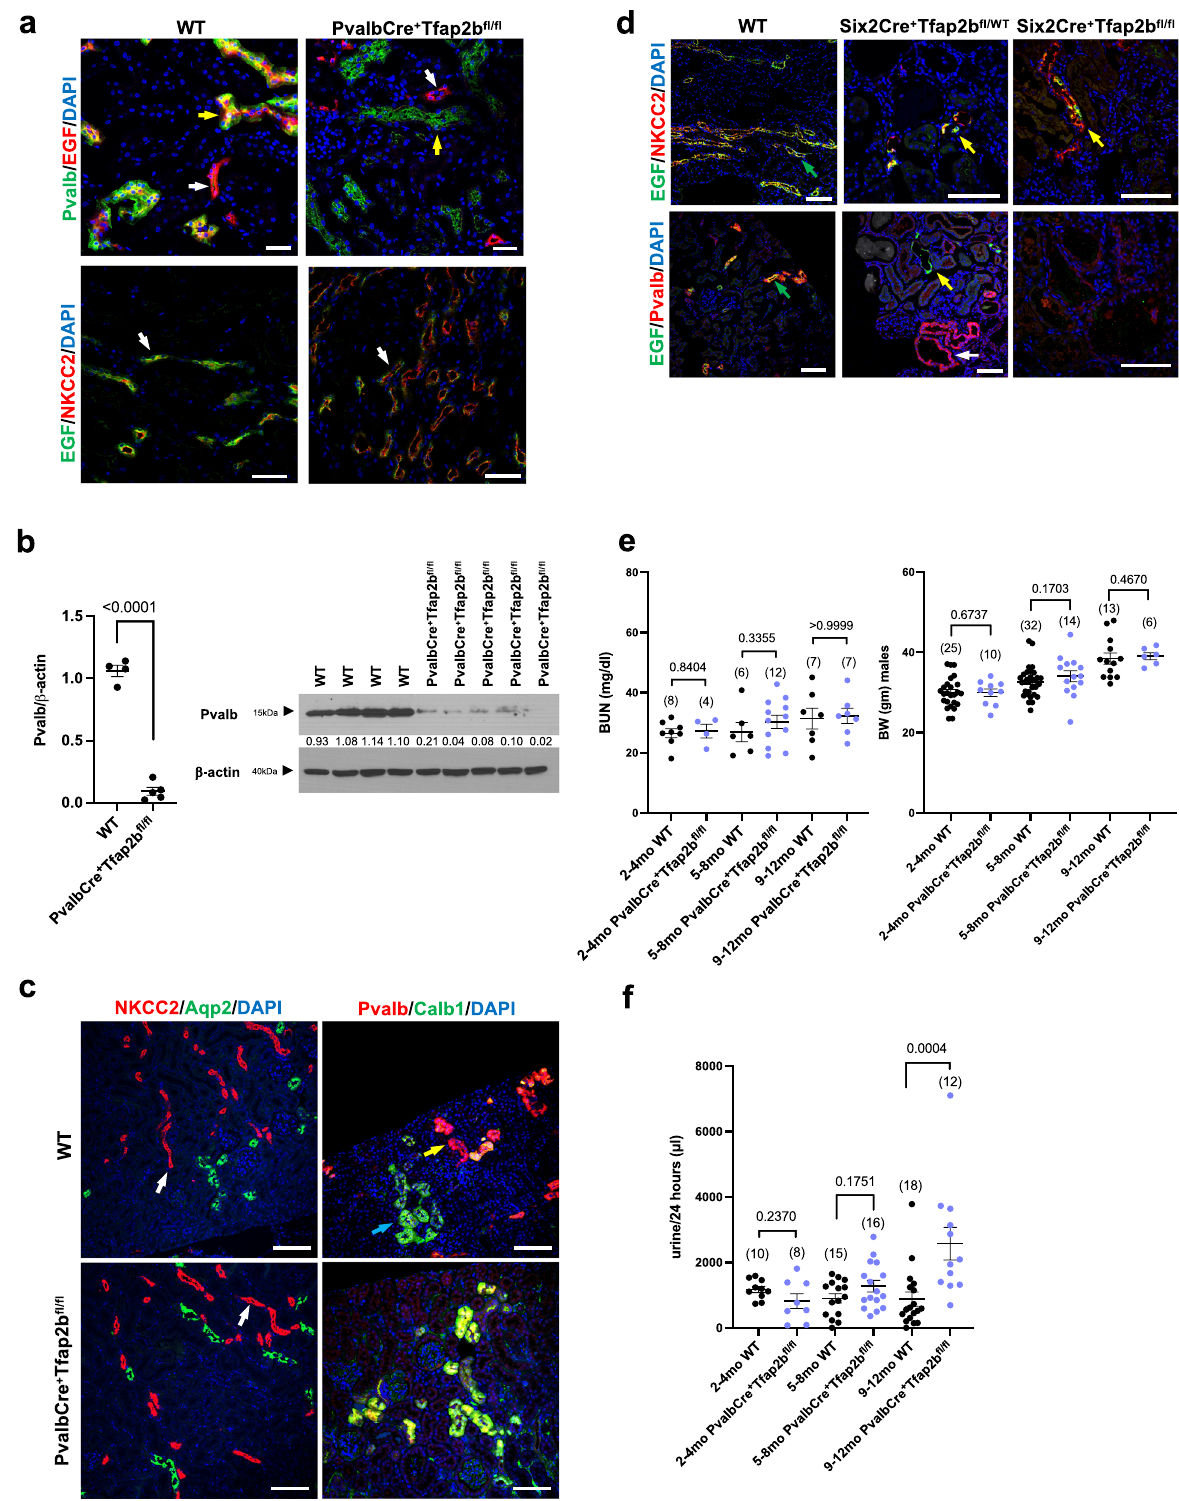
attenuated mTOR hyperactivation and partially rescued the renal fi brosis and cyst formation phenotype in these mice 17 . Our fi ndings in Six2Cre + Tfap2b fl / fl mice that survived to 1-2